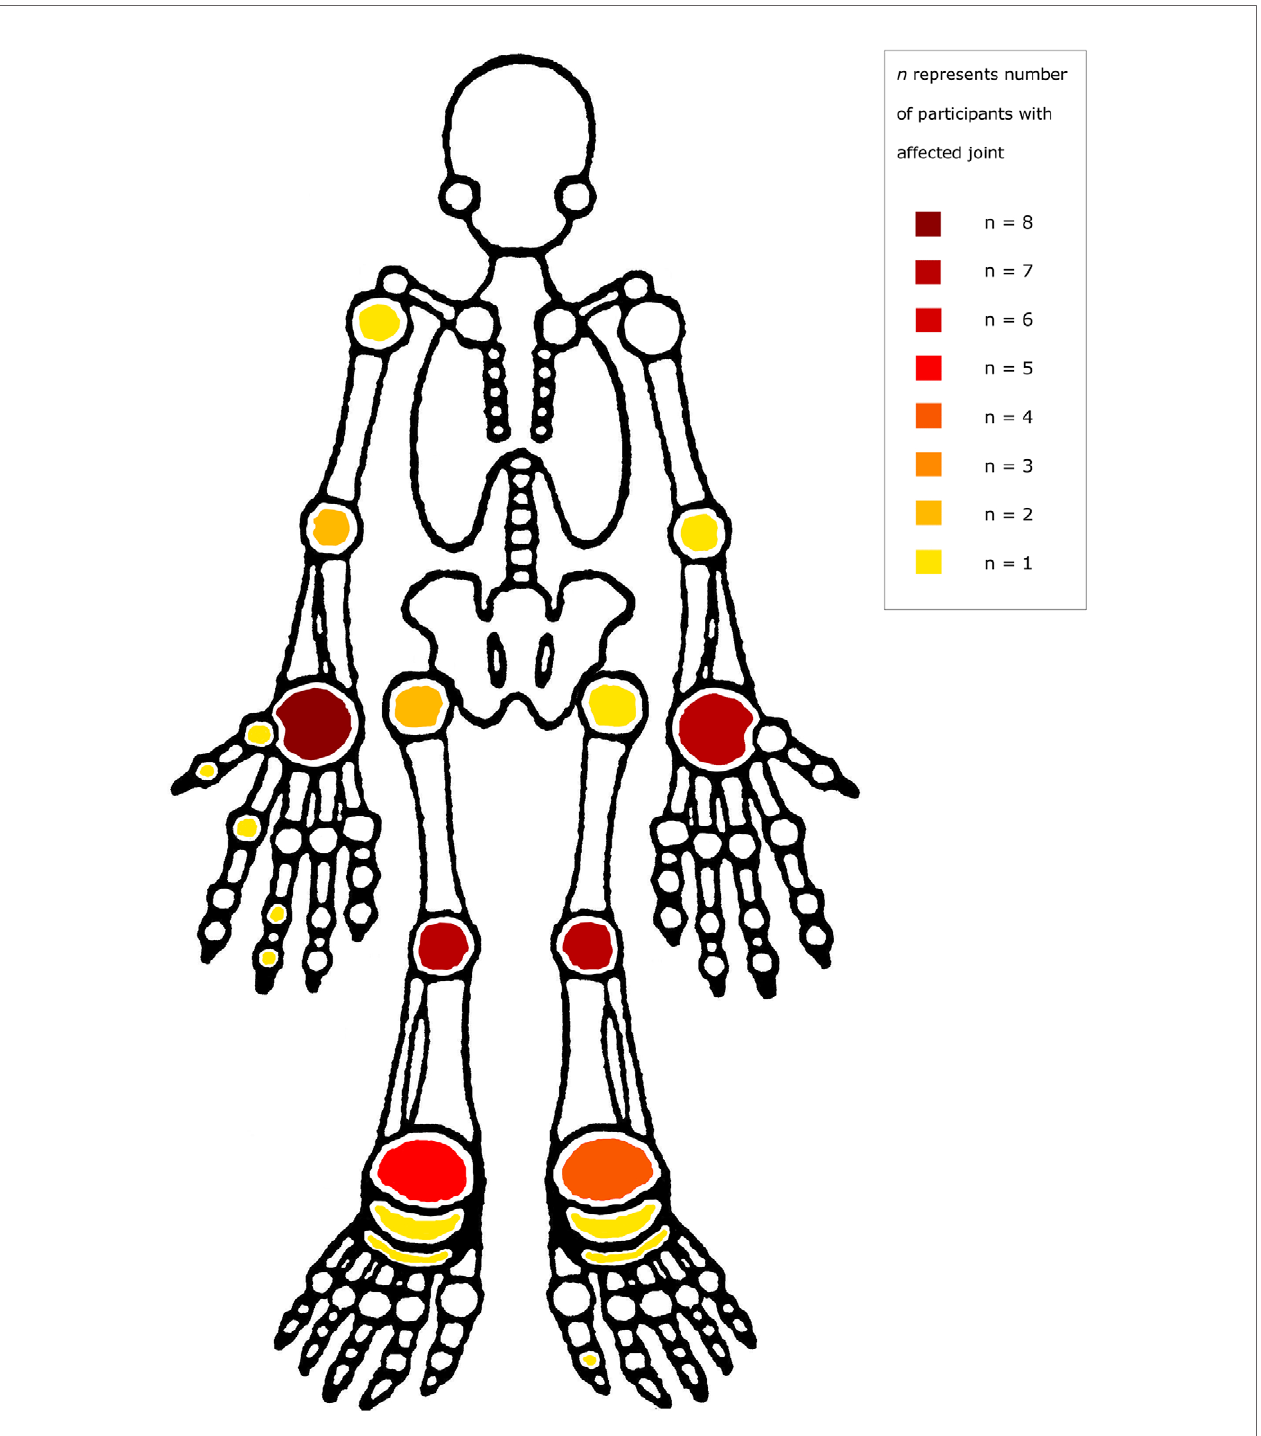
FIGURE 1 | Distribution of joint